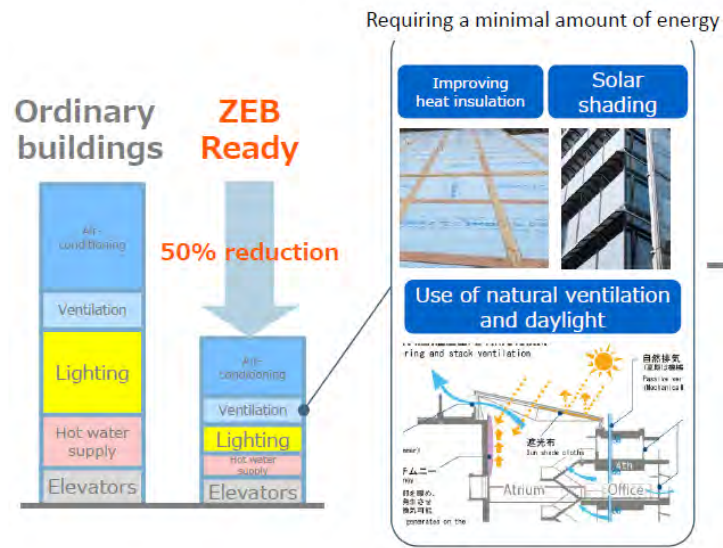
Figure 3. Reducing Energy consumption by using passive heating and cooling systems